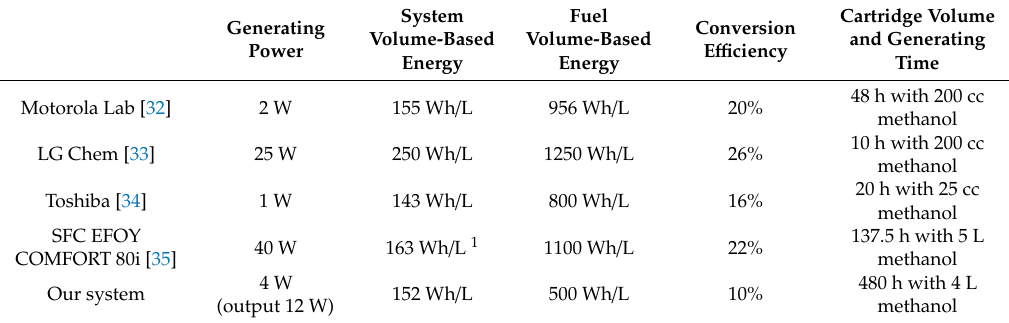
Table 1. Performance specifications of the DMFC generating systems reported in the literature